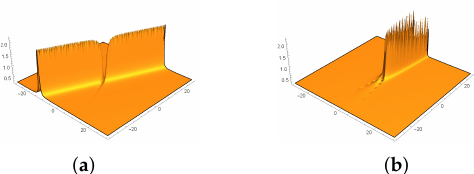
Figure 12. Degenerate two-solution interaction via the solution in Equation (26a): ( a ) antidark soliton as z → ± ∞ , where ρ = 0.5, φ = 0, c 1 ( z ) = 0, c 2 ( z ) = z and γ 1 = 1; ( b ) antidark soliton as z → ± ∞ , where ρ = 0.5, φ = 0, c 1 ( z ) = 0, c 2 ( z ) = z 2 and γ 1 = 1.